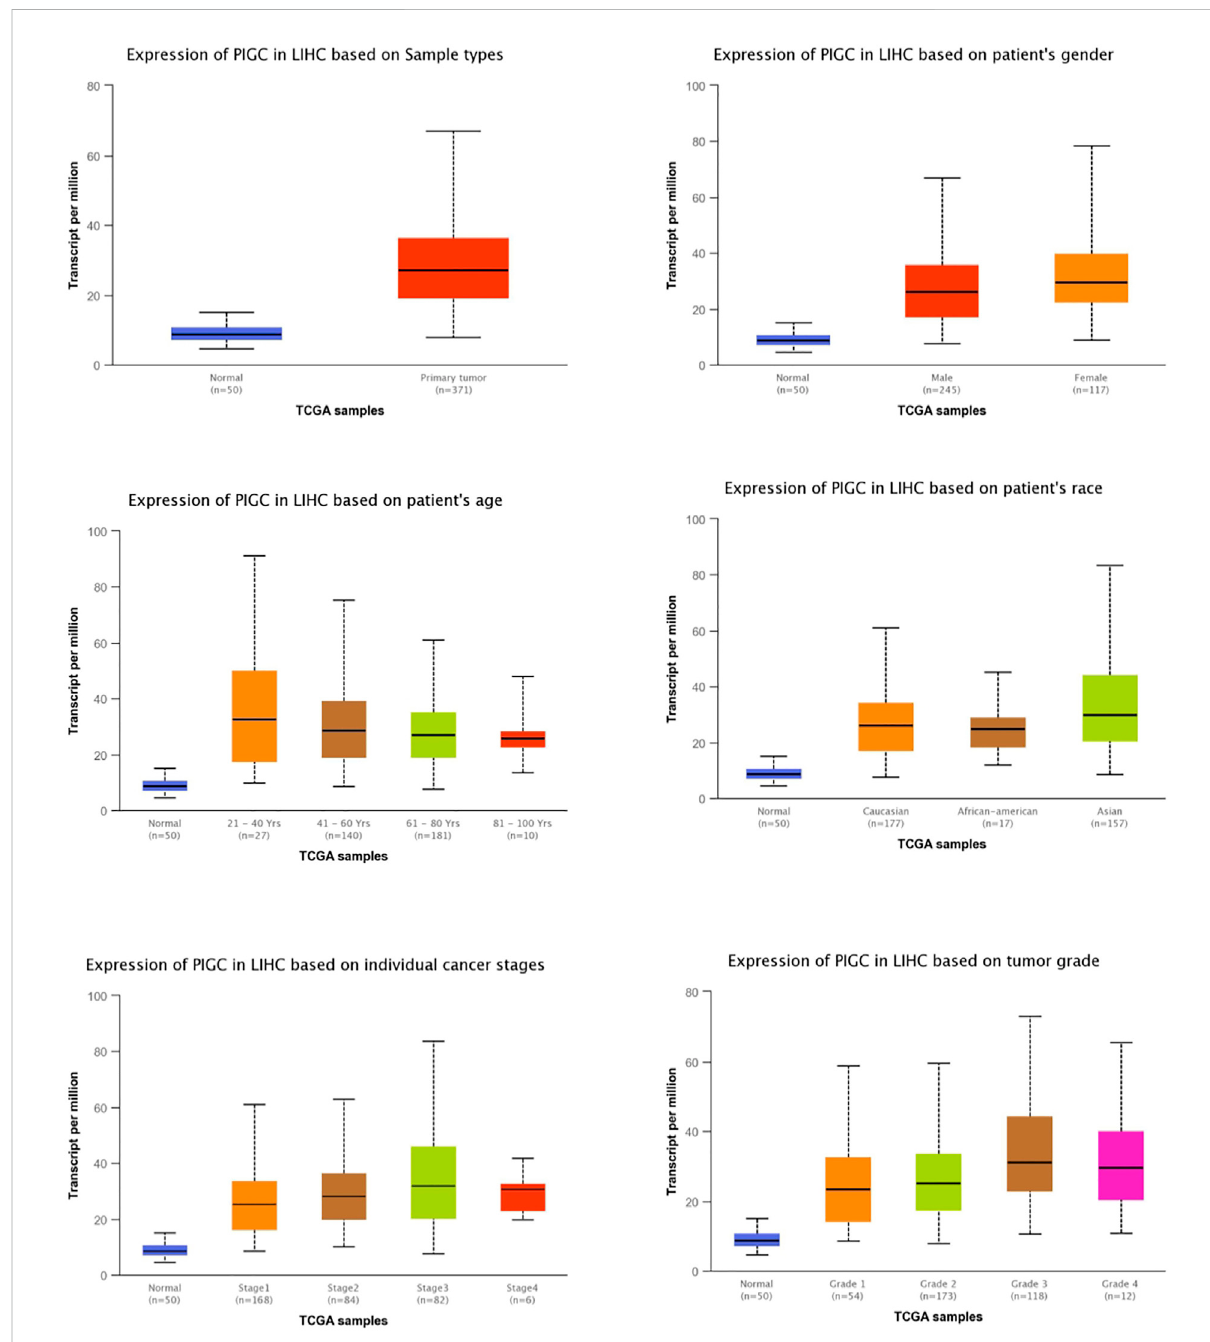
FIGURE 3 The relationship of PIGC Expression with Clinical Characteristics of HCC Patients based on gender, age, and other criteria (UALCAN).